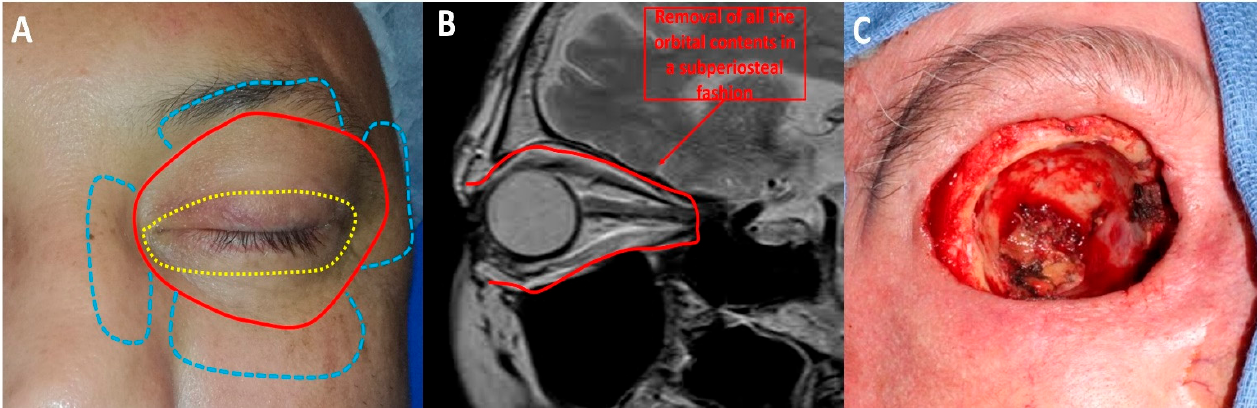
Figure 2. Orbital exenteration: ( A ) Several techniques have been described: eyelid-sparing orbital exenteration (yellow), total orbital exenteration (red) and orbital exenteration extended to surrounding orbital structures (blue). ( B ) Orbital exenteration consists of removing all the orbital contents. ( C ) Intraoperative photograph of a case of total orbital exenteration.